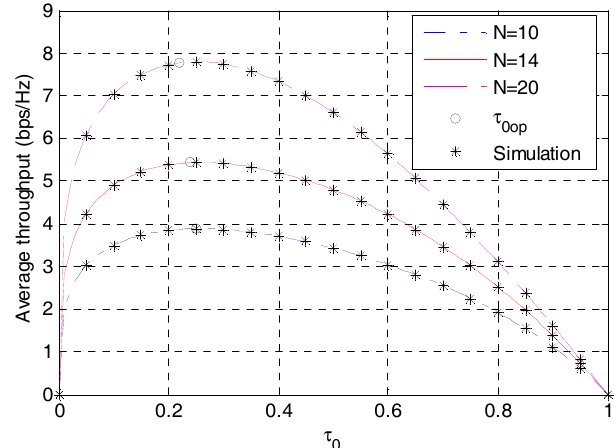
Figure 8. Average throughput versus the EH time fraction with different number of circles.